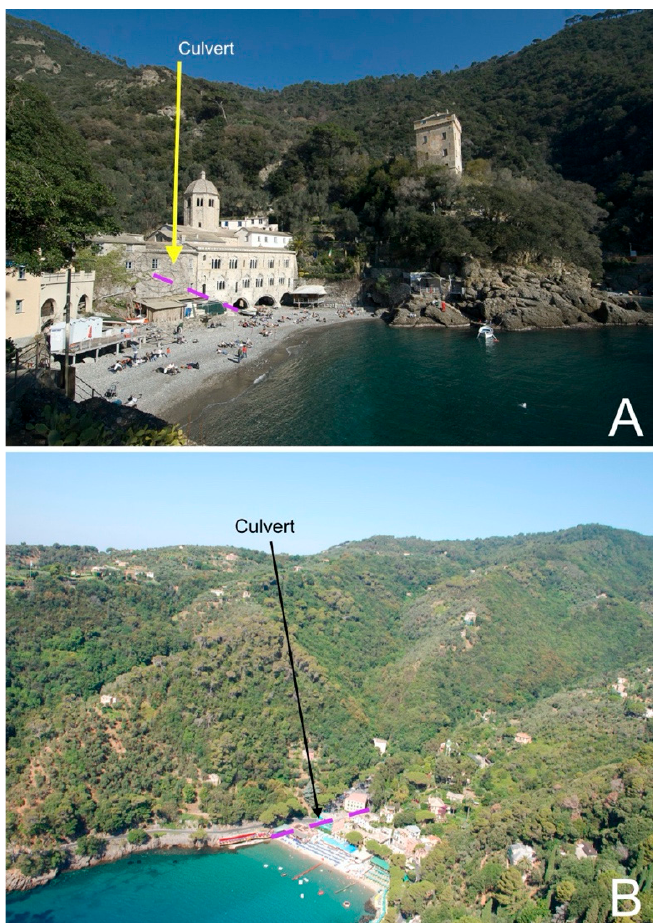
Figure 13. Culverts at the mouth of ( A ) San Fruttuoso (Figure 1, catchment n. 3) and ( B ): Paraggi (Figure 1, catchment n. 8).